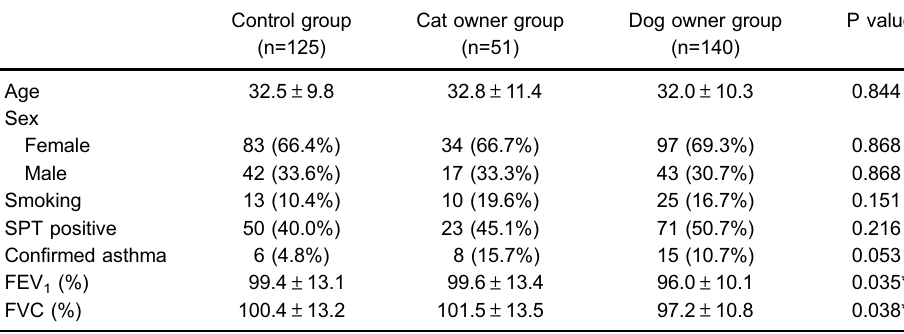
Table 1. Characteristics and outcomes of the study